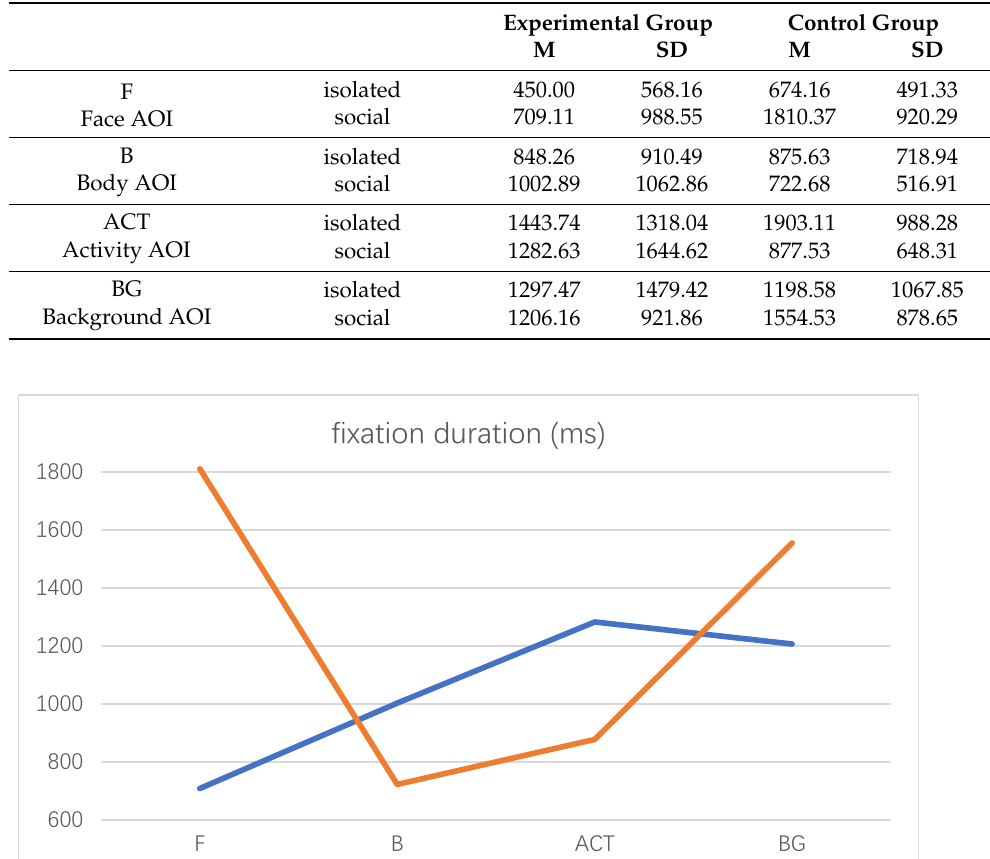
Table 3. Fixation duration of experimental group (autistic children) and control group (TD children) in different scenes. (Unit: ms).